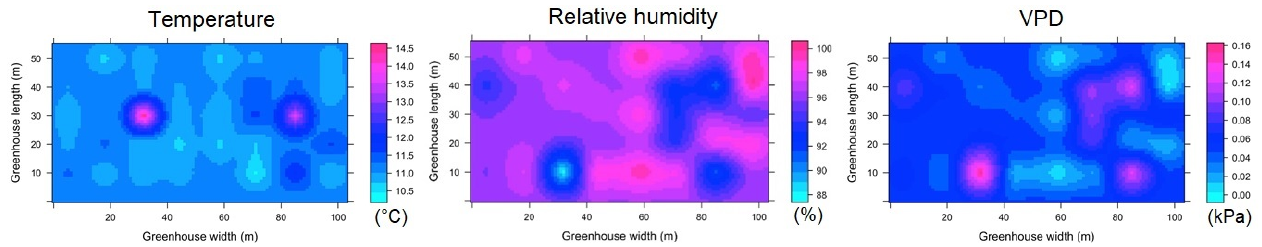
Figure 7. Spatial distribution predicted by kriging, for temperature, relative humidity and VPD in MG and for ESRL 1. MG and for ESRL